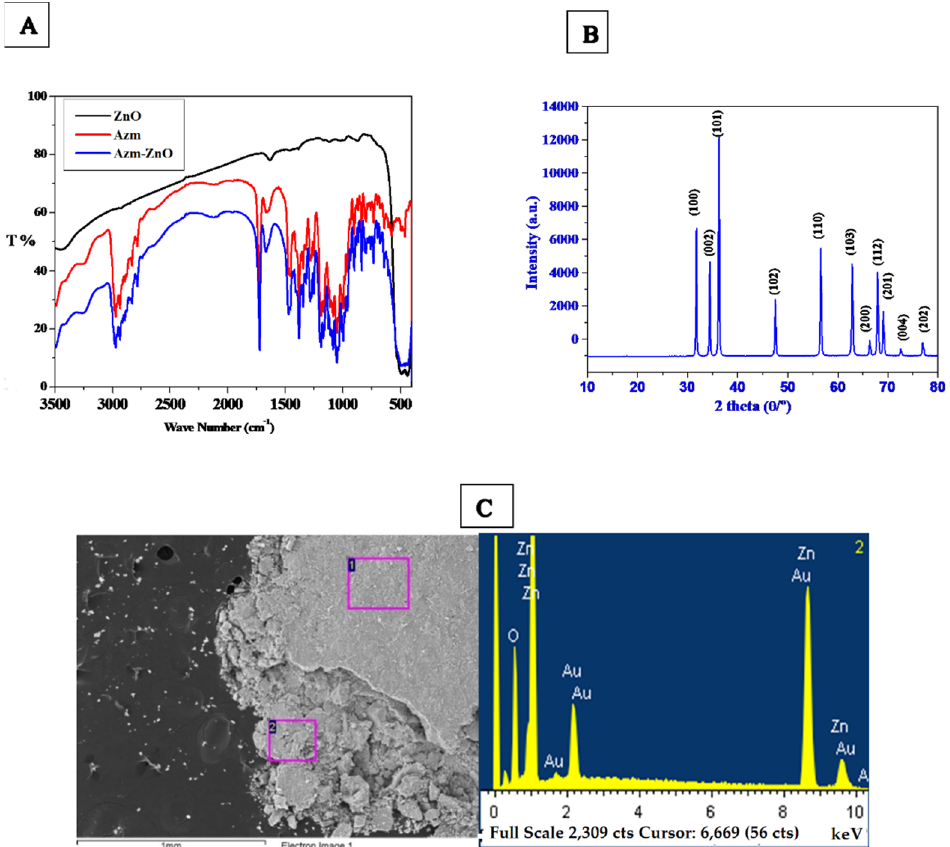
Figure 1. ( A ) FT-IR spectra of ZnONPs, AZM, and AZM-ZnO nanoparticles; ( B ) typical XRD patterns of the prepared ZnO nanoparticles (note: The numbers above the peaks correspond to the miller index (hkl) values of hexagonal ZnO); ( C ) EDXS spectra of the investigated ZnONPs. Table 2. FT-IR spectra data of ZnONPs, AZM, and AZM-ZnO nanoparticles. ZnONPs AZM AZM-ZnO Nanoparticles Band